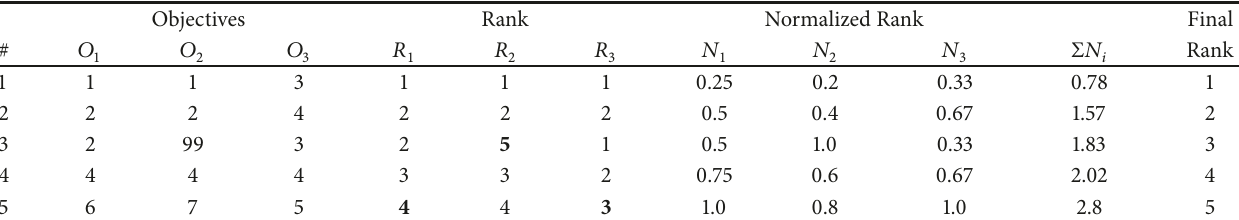
Table 3: Example of sum of ranks for a 3-objective problem. Lower objective scores and ranks are preferred. The maximum rank for each objective 𝑅 푖 used for normalization is in